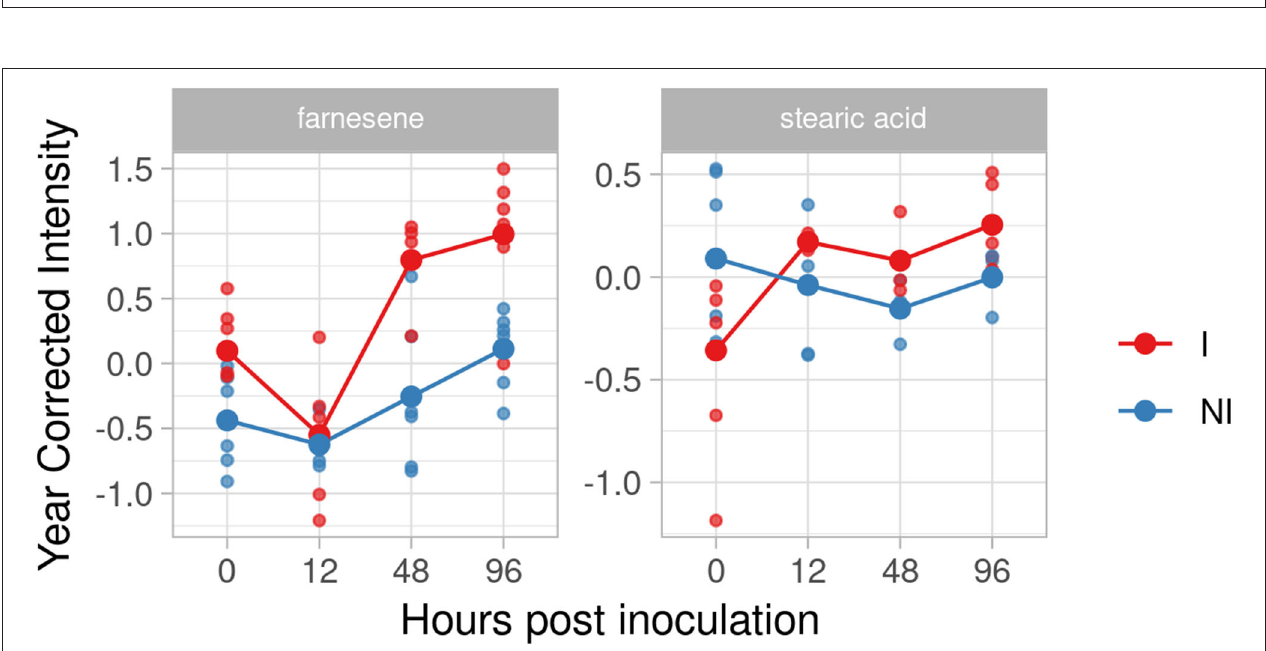
FIGURE 6 | Trend graph over time of putative biomarkers of resistance to Plasmopara viticola in F12P160 genotype inoculated (Red) and not inoculated (Blue). Values of the 2 years are reported subtracting the year’s effect.